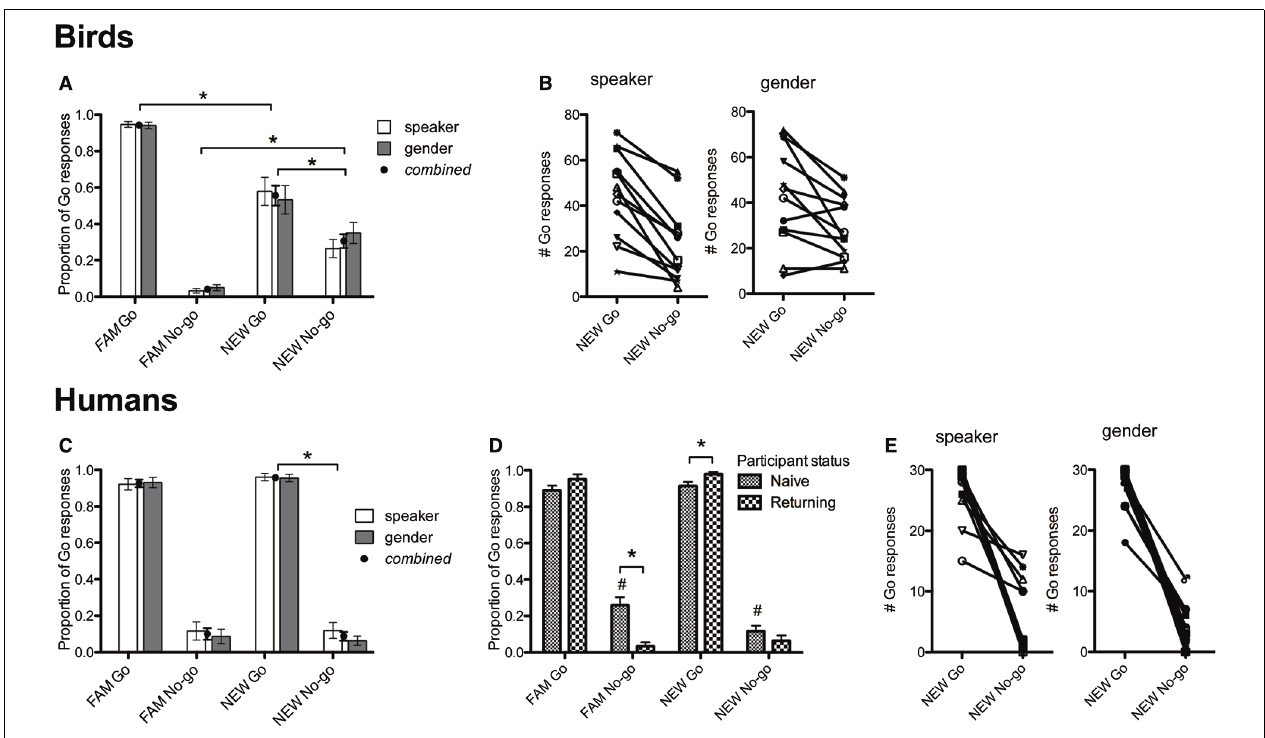
FIGURE 3 | Group level performance of birds (A) and humans (C), and individual level performance of birds (B) and humans (E) on Experiment 2. Black circles represent the combined average of performance on speaker and gender normalization conditions (which were not significantly different from each other). Asterisks in (A) and (C) indicate that birds and humans correctly discriminated between NEW vowels